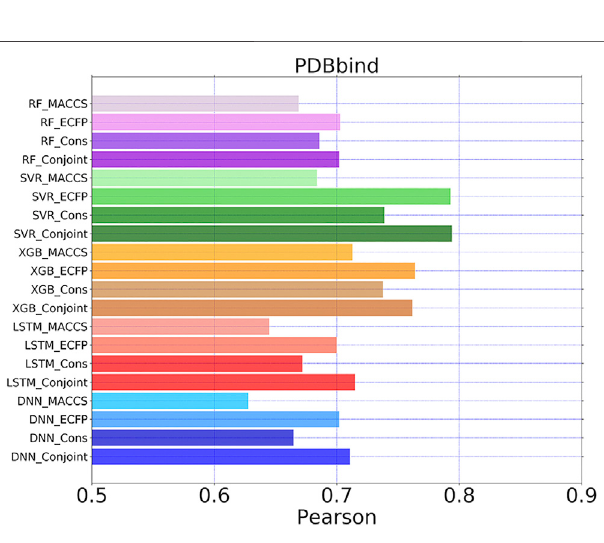
Frontiers in Pharmacology |